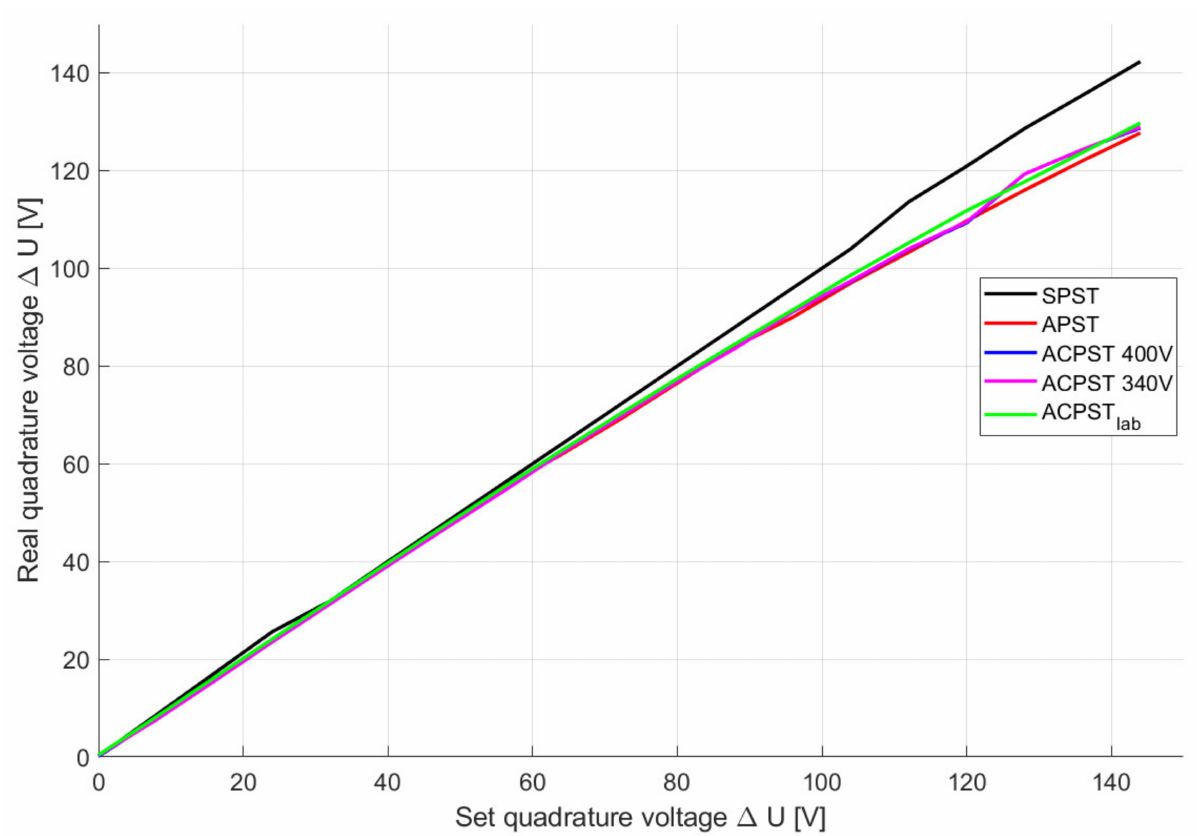
Figure 13. Injected real quadrature voltage versus set quadrature voltage for all PST